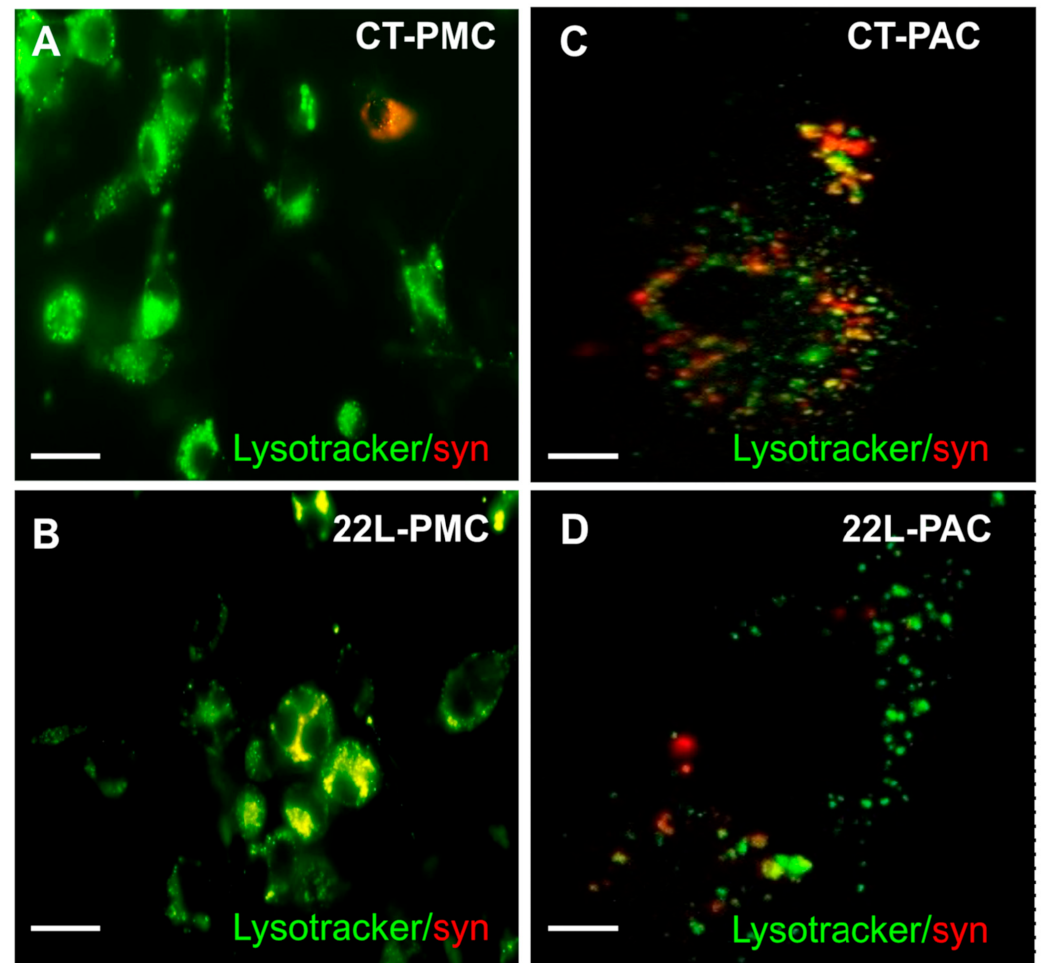
Figure 4. Imaging of phagocytic activity using LysoTracker assay. Representative images of CT-PMCs ( A ), 22L-PMCs ( B ), CT-PACs ( C ), and 22L-PACs ( D ) exposed to pHrodo Red-conjugated CT-syn (red) and incubated for 6 h in the phagocytic assay media containing LysoTracker Green. Scale bars = 50 µ m ( A , B ) and 10 µ m ( C , D